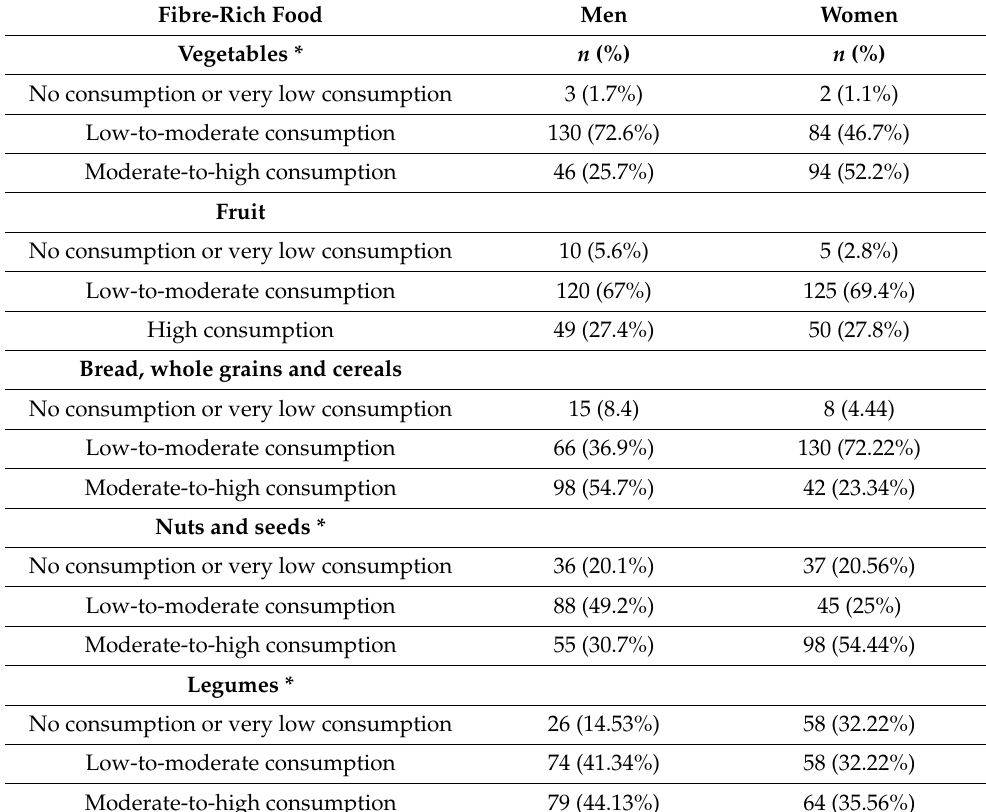
Table 2. Frequency of fibre-rich food consumption according to gender.